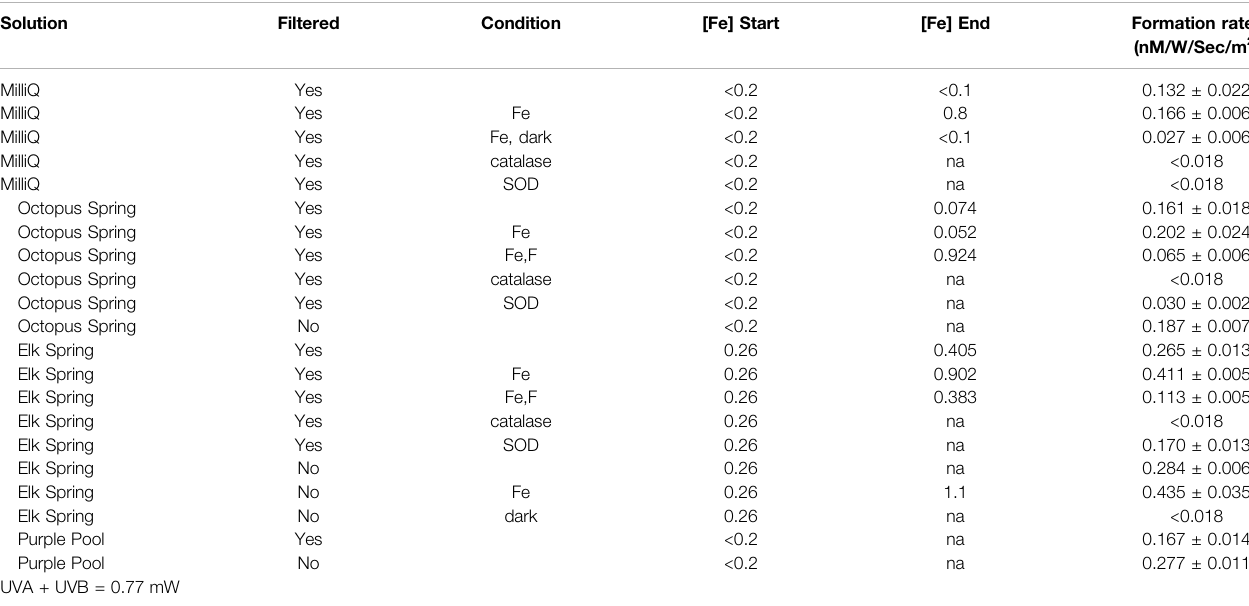
TABLE 4 | Experimental conditions and formation rates for laboratory